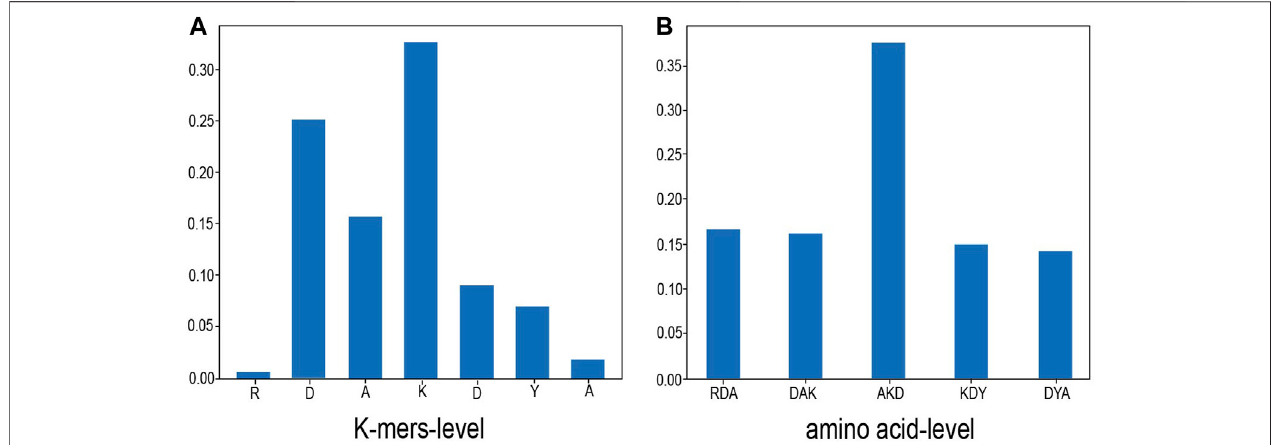
FIGURE3| Attentiondistribution.This fi gureshowstheattentionvisualizationresultofoneofthesamples(fromthe135thaminoacidofprotein1Z0J_AinDset186, the sample sequence is “ RDAKDYA ” and the target amino acid is “ K ” ). (A) shows the proportion of K-mers – level attention distribution and (B) shows the distribution of amino acid – level attention. As shown in the fi gure, the center position has the highest proportion of attention, which is also consistent with the task of protein interaction sites.